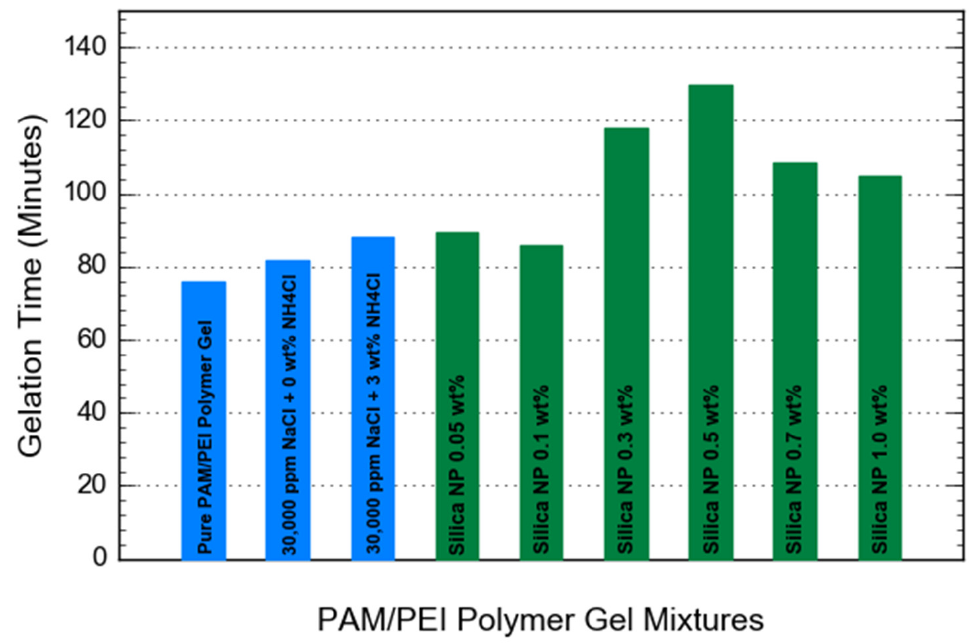
Figure 7. Summary of gelation time for PAM/PEI polymer gel with different concentrations of silica silica NP.